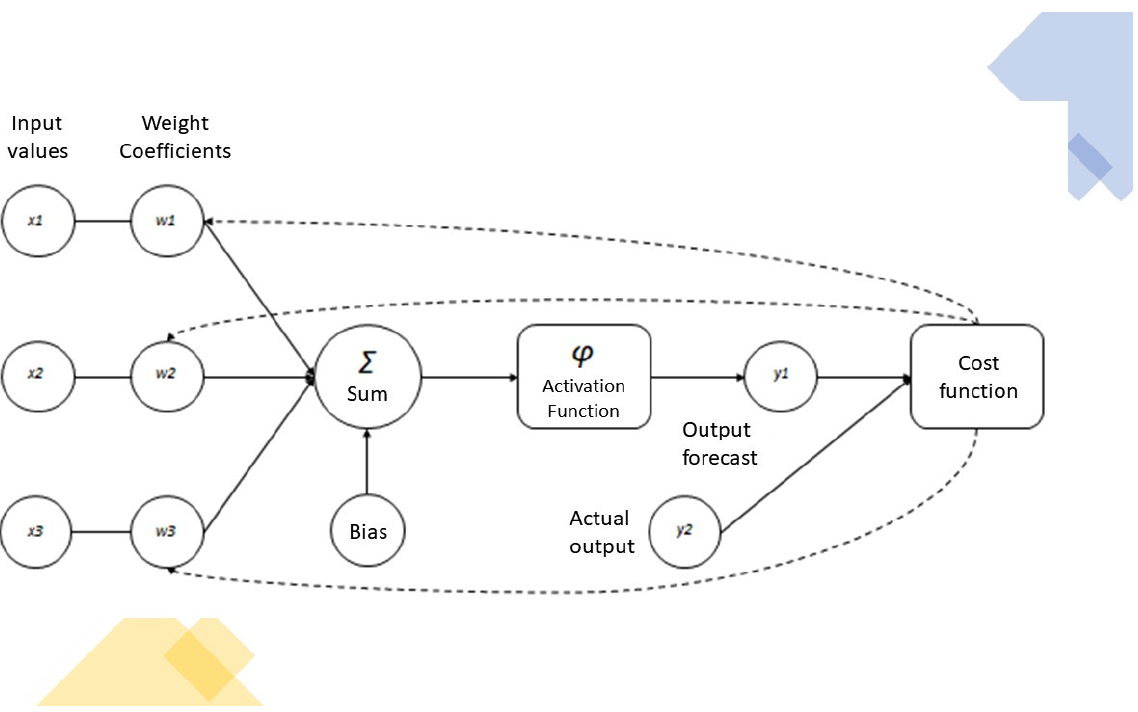
Figure 2. Diagram showing how the neural network processes the input to generate an output signal.